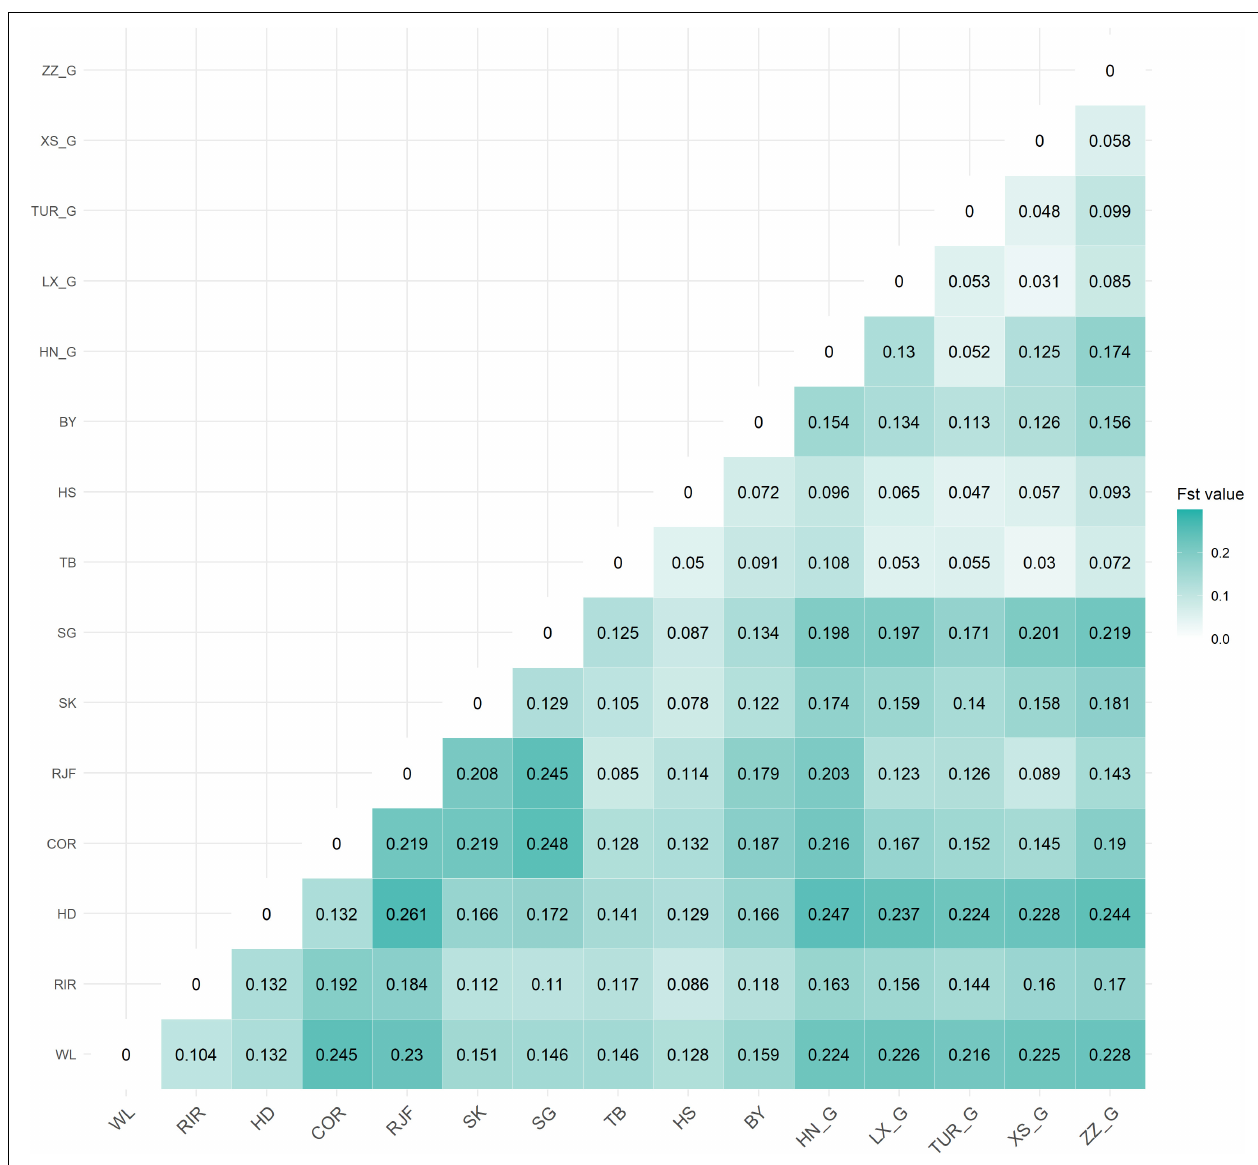
FIGURE 2 | Pairwise estimates of genetic differentiation (F ST ) between fifteen populations.